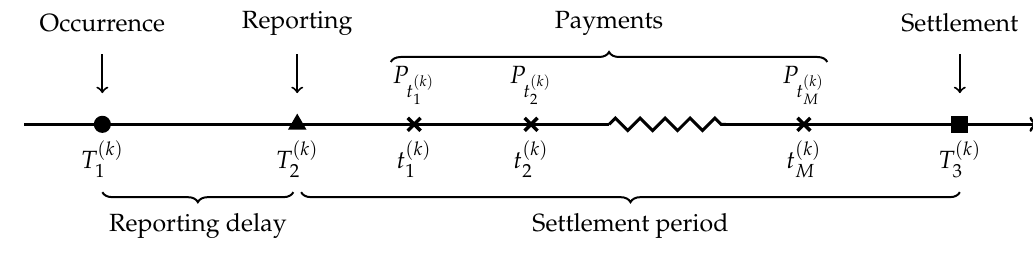
Figure 1. Development of claim k